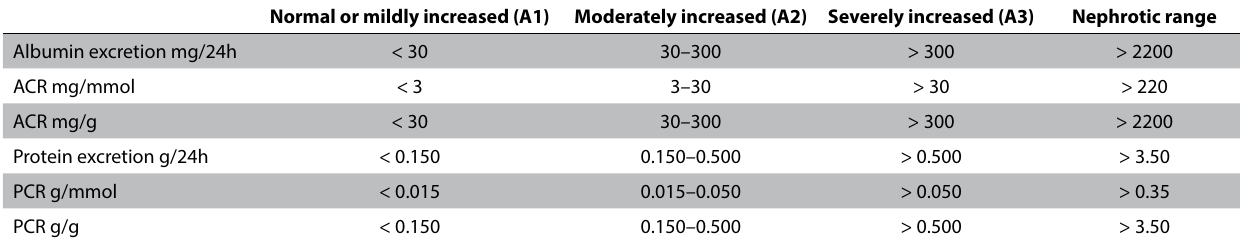
Table I. The relationship between the categories for albuminuria and proteinuria. Adapted from Eknoyan et al. 6 Normal or mildly increased (A1) Moderately increased (A2) Severely increased